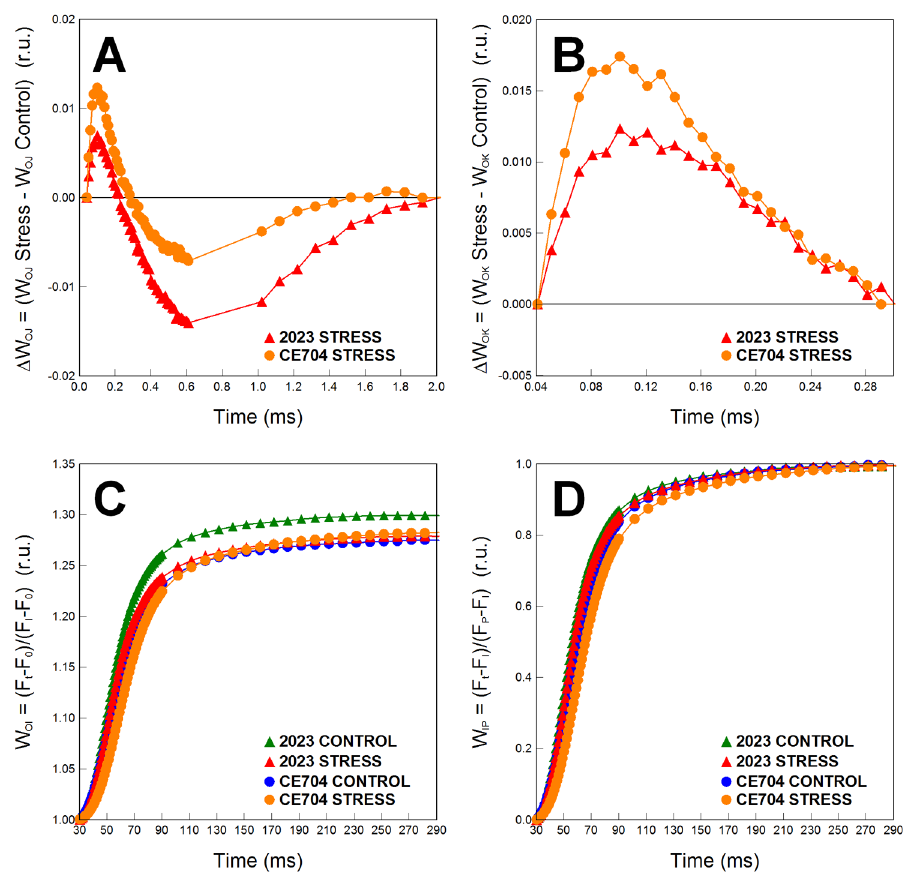
Fig 4. The difference kinetics and the relative variable fluorescences calculated from OJIP analysis of two maize genotypes (2023 and CE704). The difference kinetics Δ W OJ ( A ) reveals the K-band; Δ W OK ( B ) reveals the L-band. Only the part between the I and P points of the OJIP curve is shown for the relative variable fluorescence W OI ( C ). The normalization of OJIP curve between the I and P points with the maximum amplitude fixed as 1 is shown as the relative variable fluorescence W IP ( D ). Plants were subjected either to normal watering (control) or to 14 days of withholding water (stress). Δ W OJ and Δ W OK were calculated from the comparisons of the stressed and control plants; the latter are represented by the zero point of the respective y axes in graphs A and B . Mean values (n = 8) are shown. r. u. ... relative units.